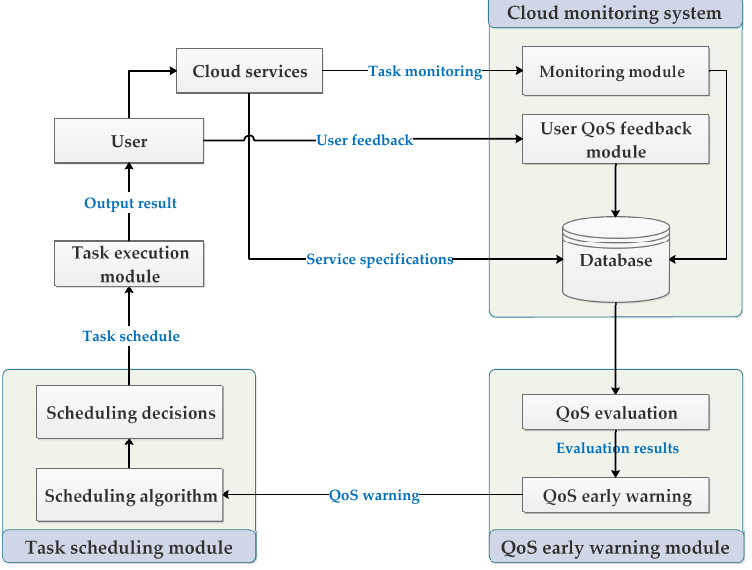
Figure 1. User QoS guarantee overall